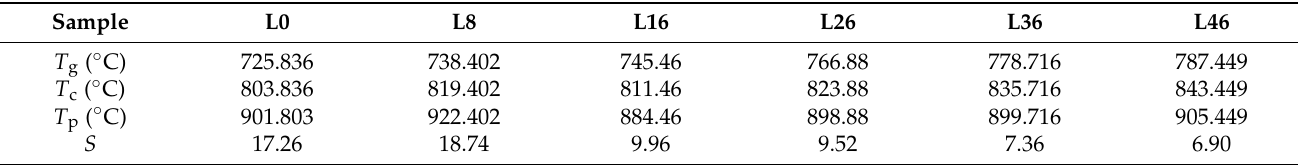
Figure 4. DSC curve of basaltic glasses from L0 to L56. Table 2. The obtained T g , T c , T p and S of